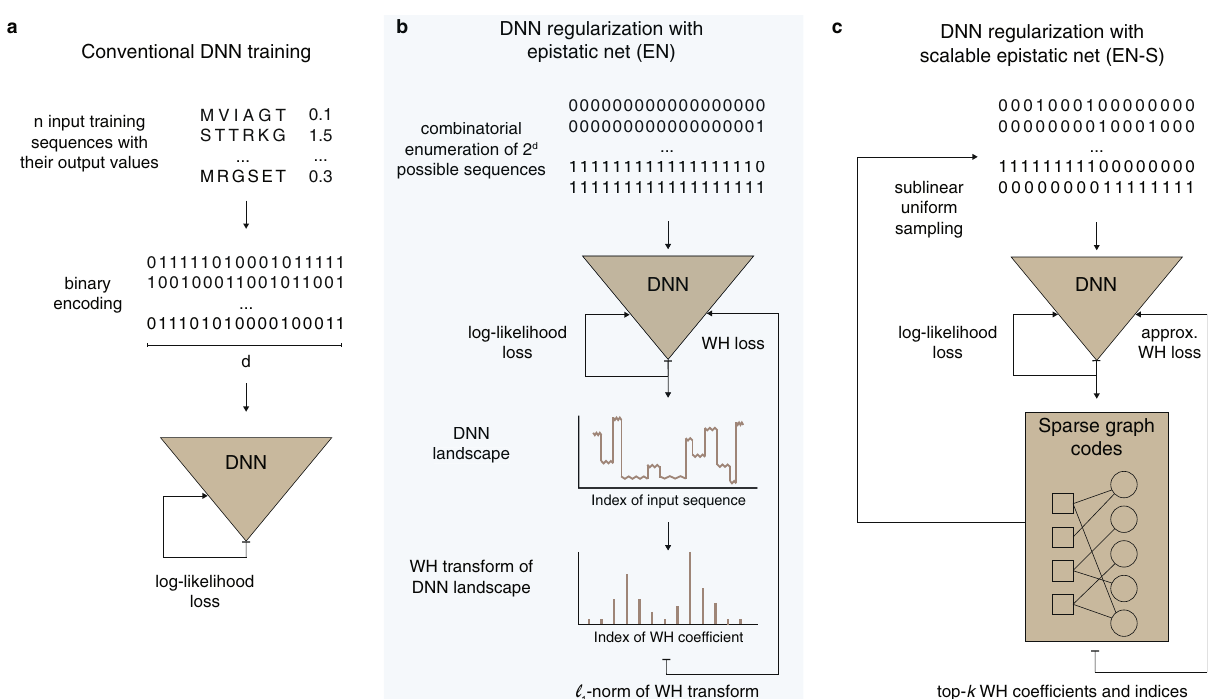
Fig. 1 Schematic illustration of our sparse epistatic regularization method, called Epistatic Net (EN). a Conventional deep neural network (DNN) training is depicted, where the log-likelihood loss (computed over n labeled training sequences encoded into binary sequences of length d ) is minimized using the stochastic gradient descent (SGD) algorithm. b In every iteration, EN queries DNN for all the 2 d possible binary input sequences, fi nds the Walsh Hadamard (WH) spectral transform of the resulting landscape using the Fast WH Transform (FWHT), and then adds the ℓ 1 -norm of the WH transform to the log-likelihood loss from panel ( a ). c In the scalable version of EN, EN-S regularizes DNN using only a few number of uniformly subsampled sequences from the combinatorial input space that casts the sparse WH recovery problem on an induced sparse-graph code. EN-S iterates between these two subproblems until convergence: (1) fi nding the sparse WH transform of DNN (using sublinear samples and in sublinear time) through peeling over the induced sparse-graph codes, and (2) minimizing the sum of the log-likelihood loss and the WH loss using